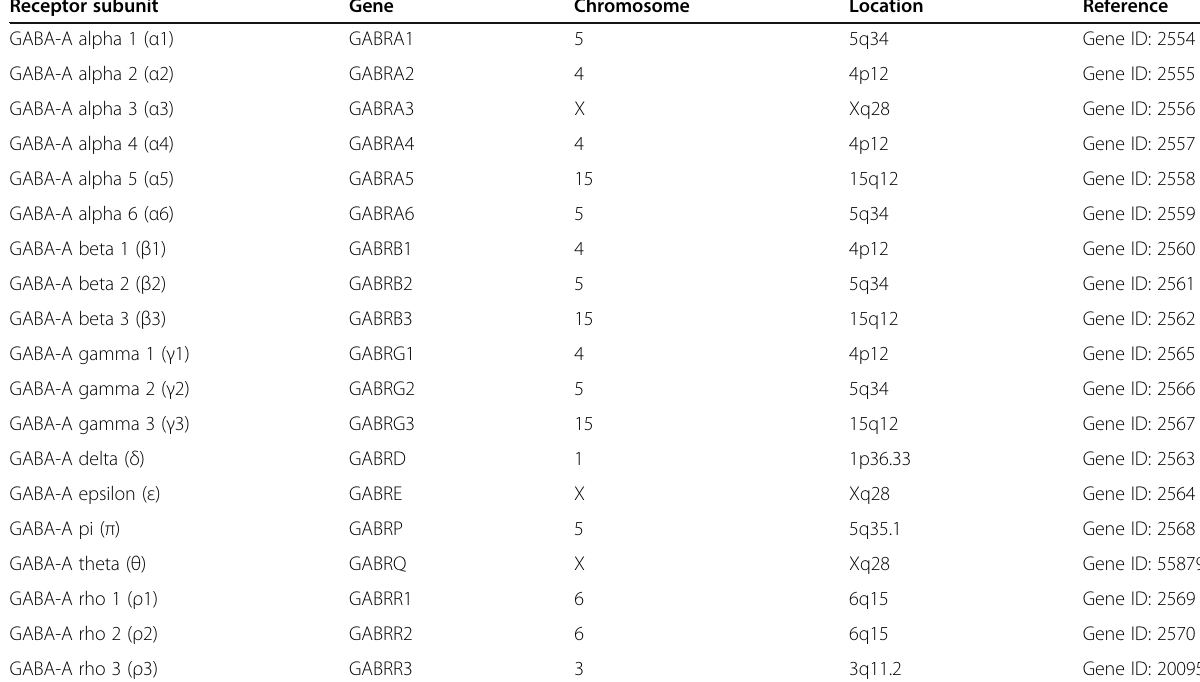
Table 1 GABA A receptor subunits Receptor subunit Gene